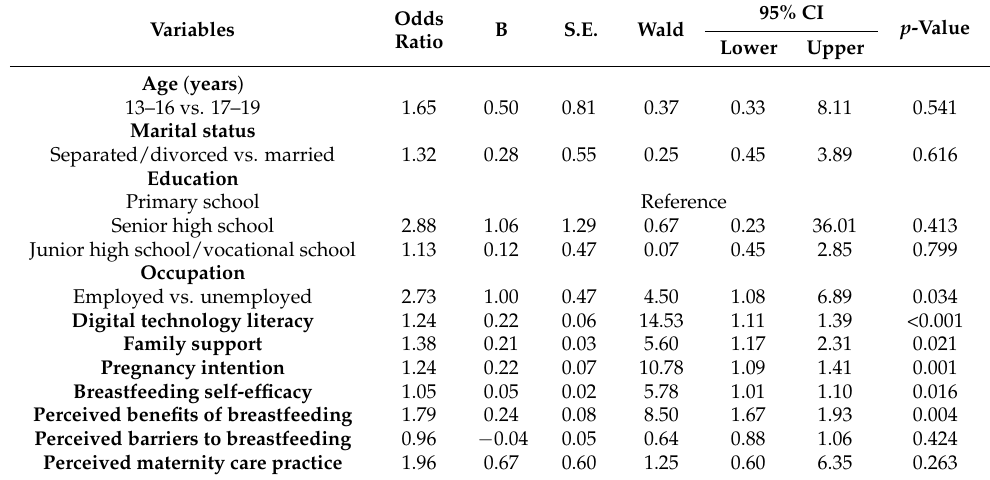
Table 4. Logistic efficiency of prediction variable for EBF among Thai adolescent mothers ( n = 253). Variables